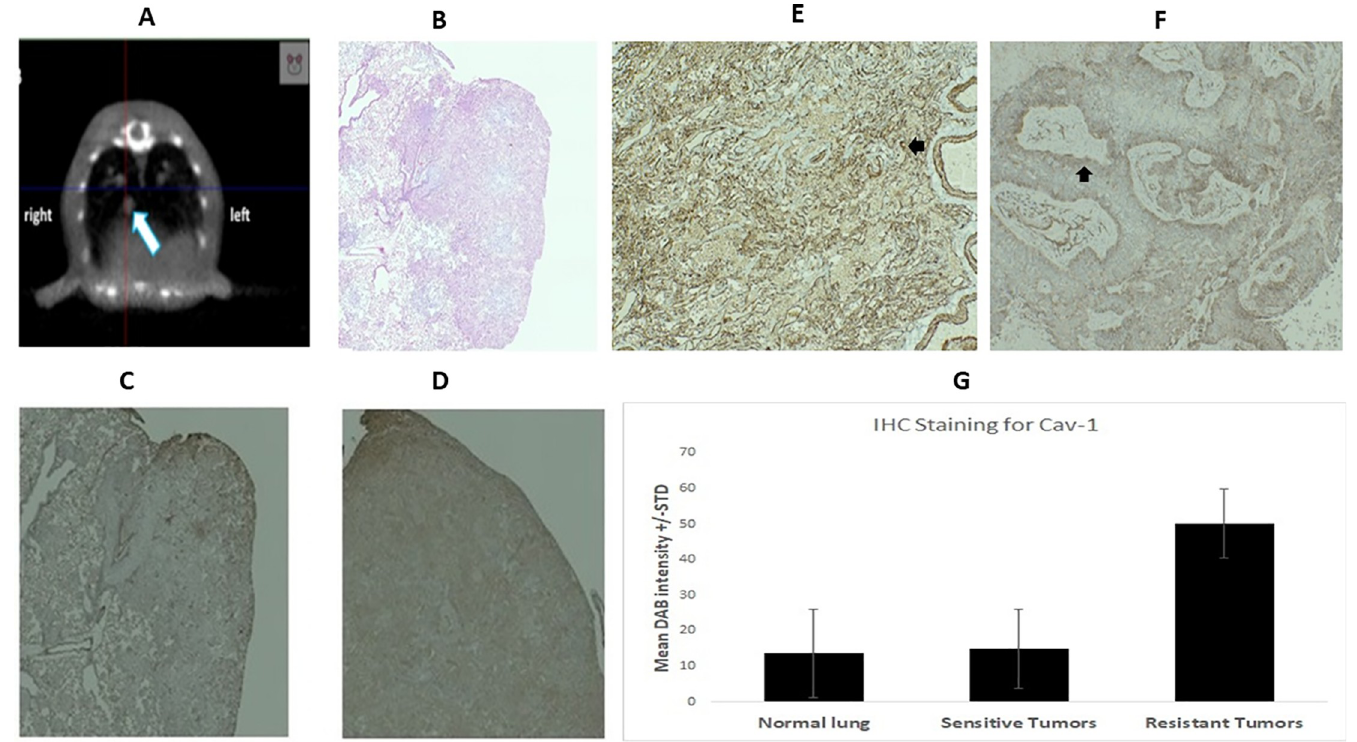
Fig 5. In vivo studies of radioresistant lung cancer in nude BALB/c mice and its histopathological characterization. (A), Orthotopic mouse model of human A549 lung cancer showed in Cone beam CT image following trans-bronchial inoculation of A549 NSCLC cells in the right lung of nude mice. White arrow shows tumor in lower lobe of right lung. ( B ), Hematoxylin and eosin (HE) staining of the orthotopic tumor in nude mice; ( C ), IHC staining of Caveolin-1 in in orthotopic lung tumor created by A549 parental cells. ( D ), IHC staining of Caveolin-1 in in orthotopic lung tumor created by A549 radio resistant cells. ( E ), IHC staining of Caveolin-1 in human adenocarcinoma cells; ( F ), IHC staining of Caveolin-1in human squamous cell carcinoma cells. ( G ), Quantification of IHC images of radiosensitive and radioresistant mouse tumor tissues.